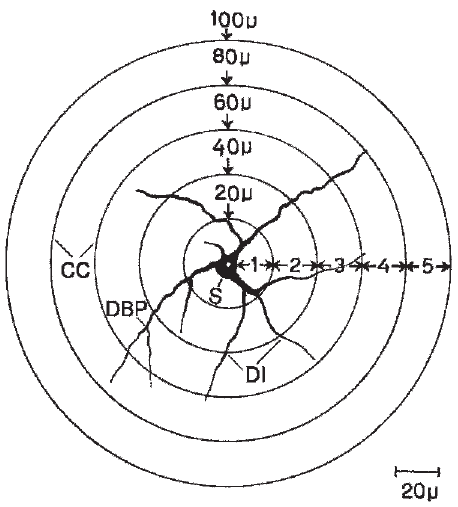
Figure 1 - Diagram of an amygdaloid neuron and the scheme of dendritic quantification. DBP – Dendritic branching points; DI – Dendritic intersections; CC – Concentric circles; S – Soma; and 1 to 5 –